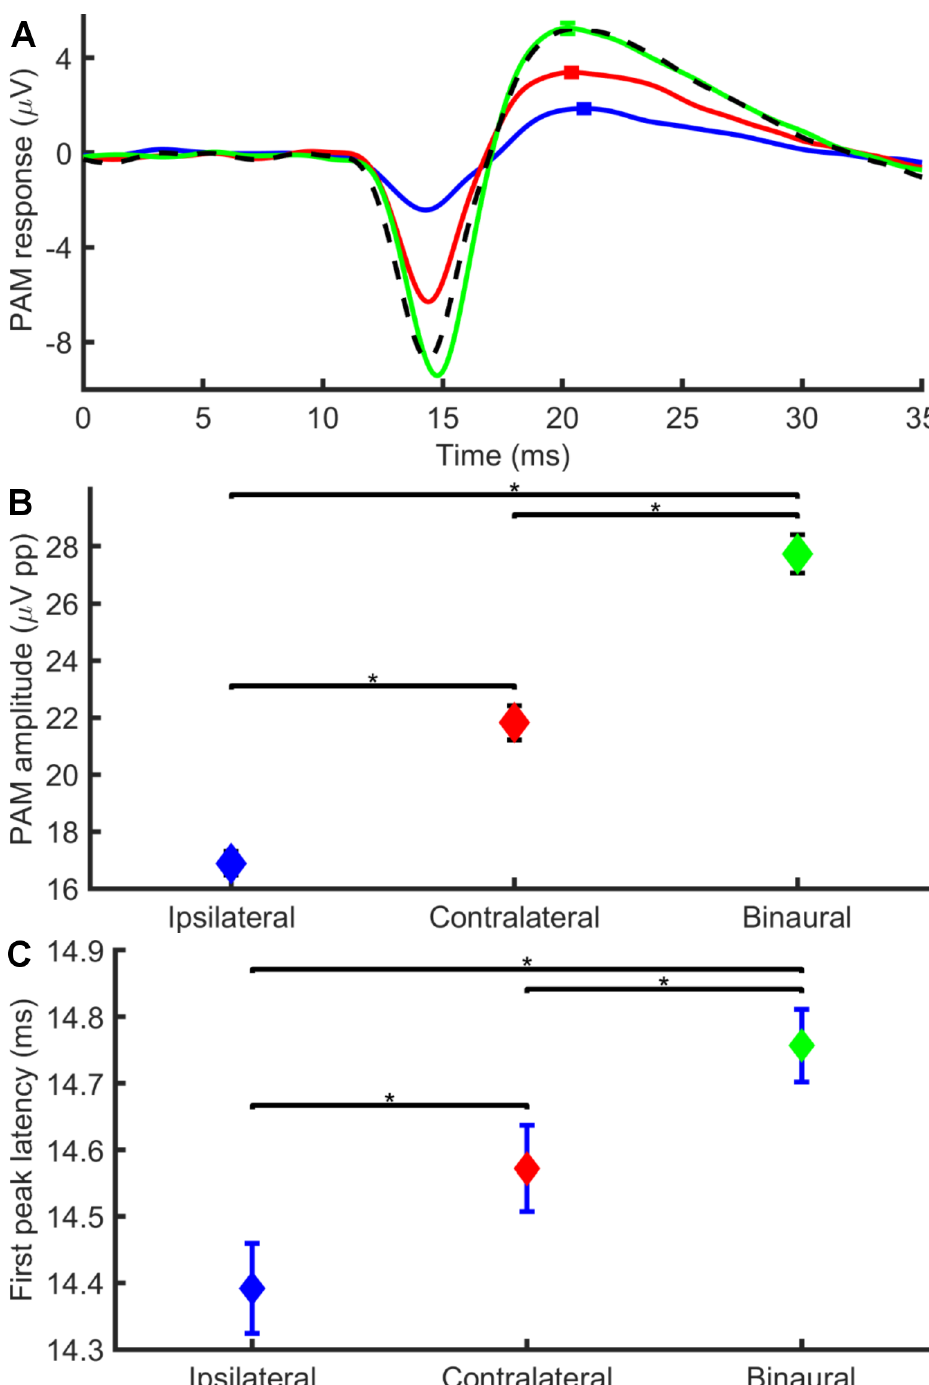
Fig 1. Average PAM response waveforms for monaural and binaural conditions. In 1A the averaged click evoked response to ipsilateral (blue line) and contralateral (red line) monaural stimulation and to binaural (green line) stimulation (n = 11 participants) are shown. When recorded with the positive electrode over the muscle and the negative electrode on the posterior pinna surface the response is biphasic with an initial negative deflection followed by a positive deflection. The linear summation of the ipsilateral (I) and contralateral(C) responses is shown (black dotted line). In 1B the average peak to peak amplitude of the click evoked PAM response are shown (n = 11 participants). On average binaural stimulation (green diamond) gave the greatest response followed by contralateral (red diamond) and then ipsilateral stimulation (blue diamond). In 1C the average latency of the first peak of the click evoked PAM